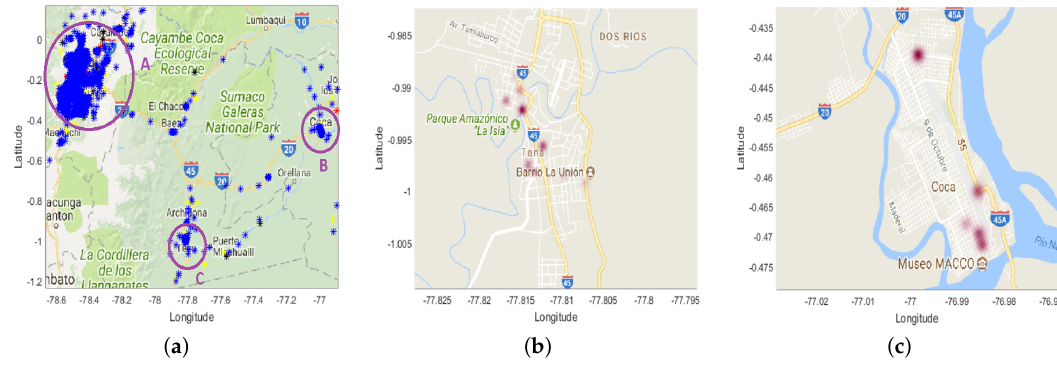
Figure 14. Scatterplot of the emergencies registered during January 2014 in ( a ) the three main cities of the provinces covered by the public safety answering point (PSAP); ( b ) Tena, the capital of Napo; and ( c ) El Coca, the capital of